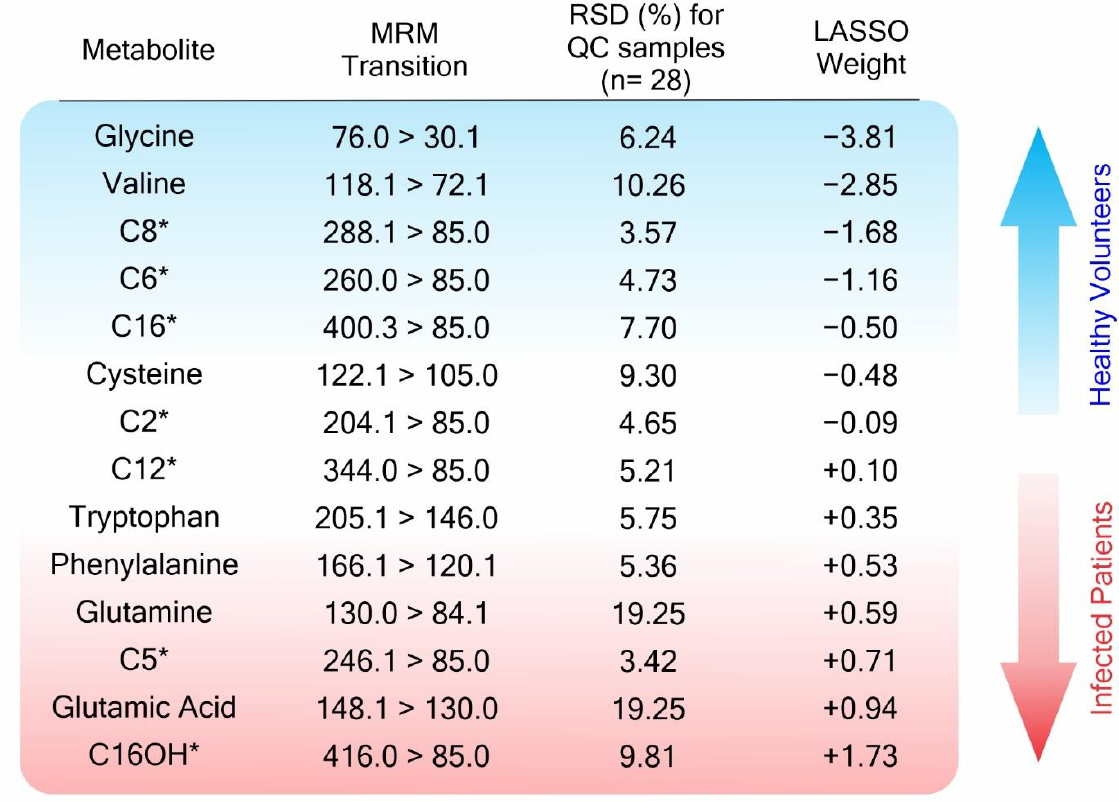
Figure 2. Metabolites selected by Lasso analysis, the multiple reaction monitoring (MRM) transitions of detection (precursor > fragment), relative standard deviation (RSD) for quality control (QC) samples, and their weights for the Lasso model. * Acylcarnitines are expressed by the number of carbons on the chain.